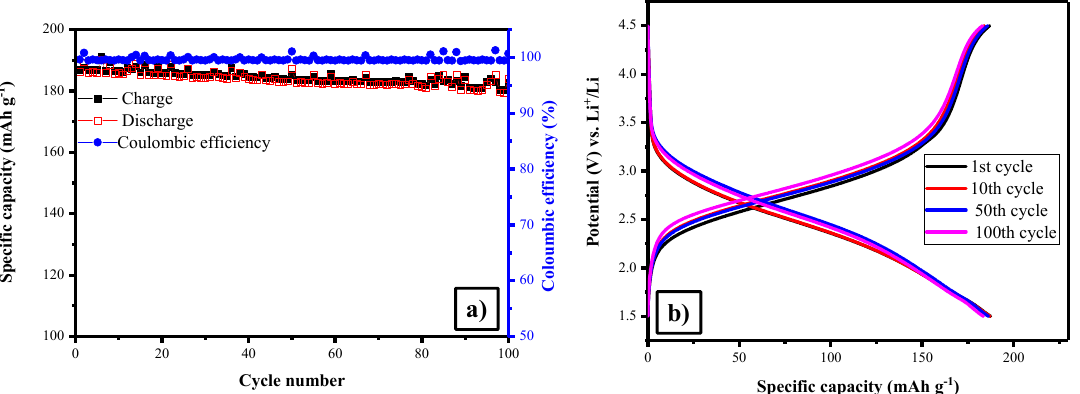
Figure 4. ( a ) Rate performance, and ( b ) columbic efficiency and capacity retention of Li 2 FeSiO 4 /C.